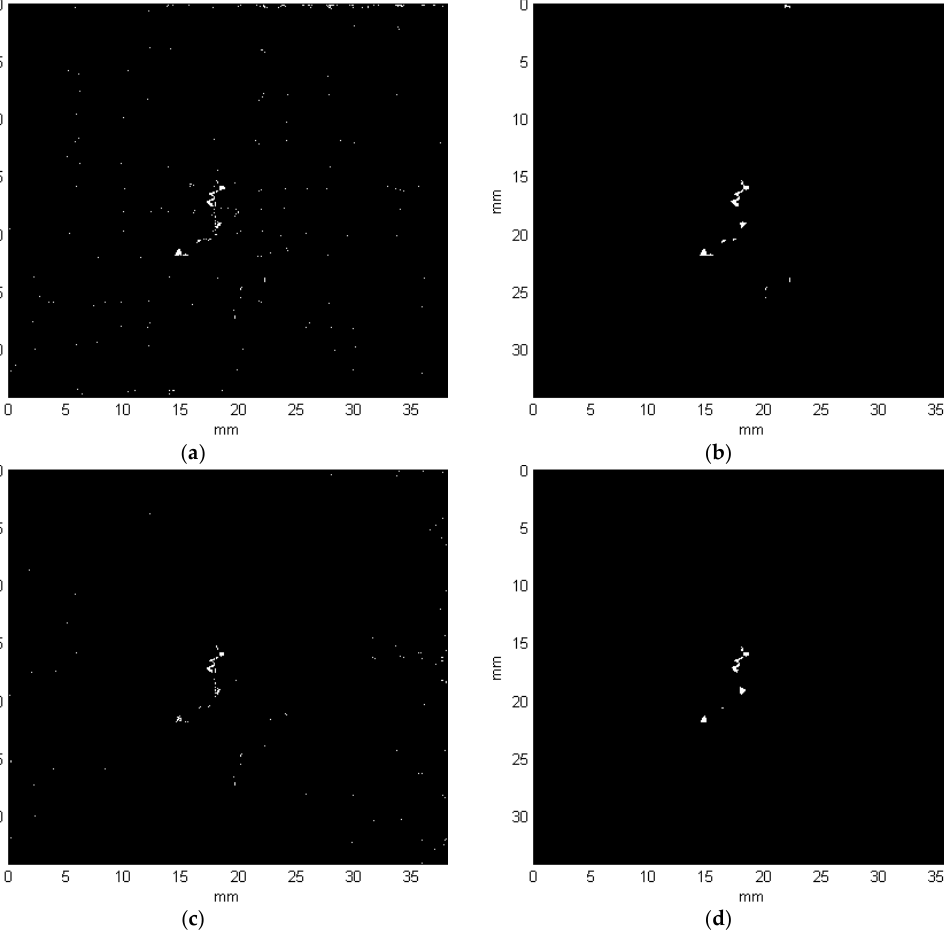
Figure 19. Binary results after thresholding using approaches: ( a ) column-based; ( b ) column-based after morphological processing; ( c ) row-based; ( d ) row-based after morphological